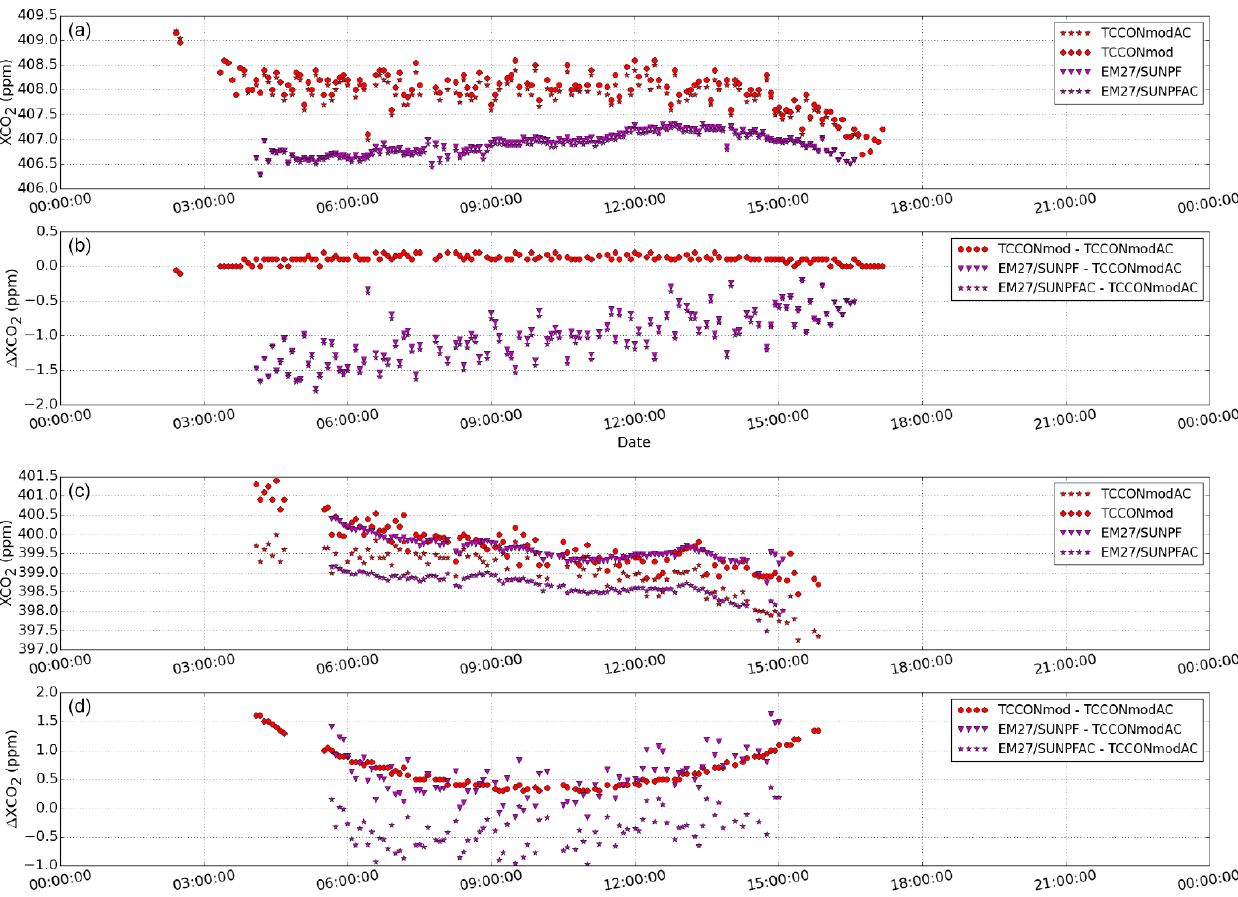
Figure 4. (a) XCO 2 plotted for TCCONmod and EM27/SUN retrievals with the TCCON a priori and with a modified a priori (calculated using in situ, AirCore, and TCCON map files; labelled with AC at the end) for measurements performed on 15 May 2017 at Sodankylä. Panel (b) shows the difference between the two retrievals in absolute units. Panels (c) and (d) show the same plots as mentioned above for measurements performed on 28 August 2017 at